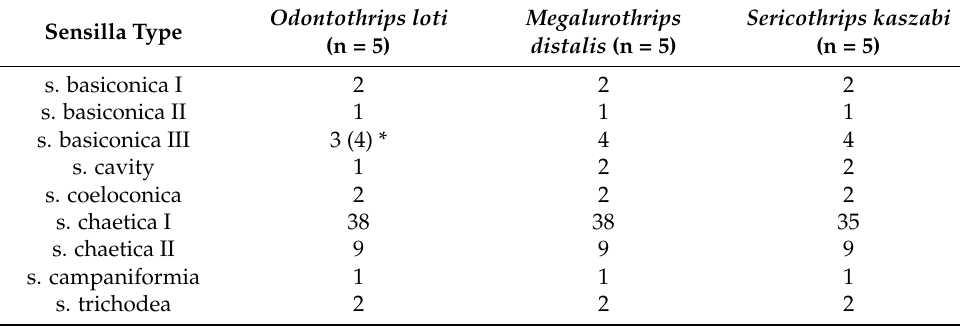
Table 1. The number of nine different types of sensilla in three thrip